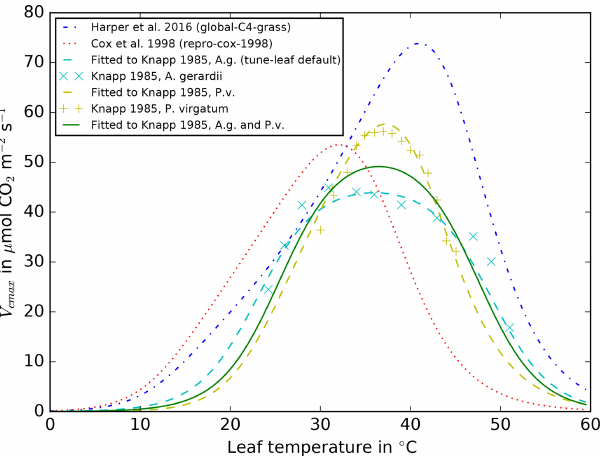
Figure 3. Mean observations from Fig. 1 in Knapp (1985) from the burned plot, early season (May–June 1983) for A. gerardii (cyan diagonal crosses) and P. virgatum (yellow vertical crosses) for net CO 2 assimilation rate against incident PAR, at 35 ± 2 ◦ C. JULES parameters are fitted to the A. gerardii observations (cyan dashed line), P. virgatum (yellow dashed line) and a combination of both (green solid line). Also shown are the relations from the repro-cox-1998 (red dotted line) and global-C4-grass runs (blue dot-dashed line) at 35 ◦ C. Fitted lines assume no water stress (i.e. β = 1) and c i = 200µmolCO 2 (molair) − 1 . Model lines have been created using the Leaf Simulator package, which repro- duces the internal JULES calculations.